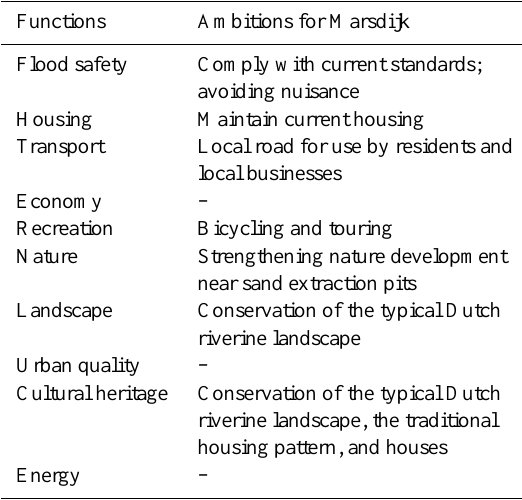
Table 5. Envisaged functions for the Arnhem